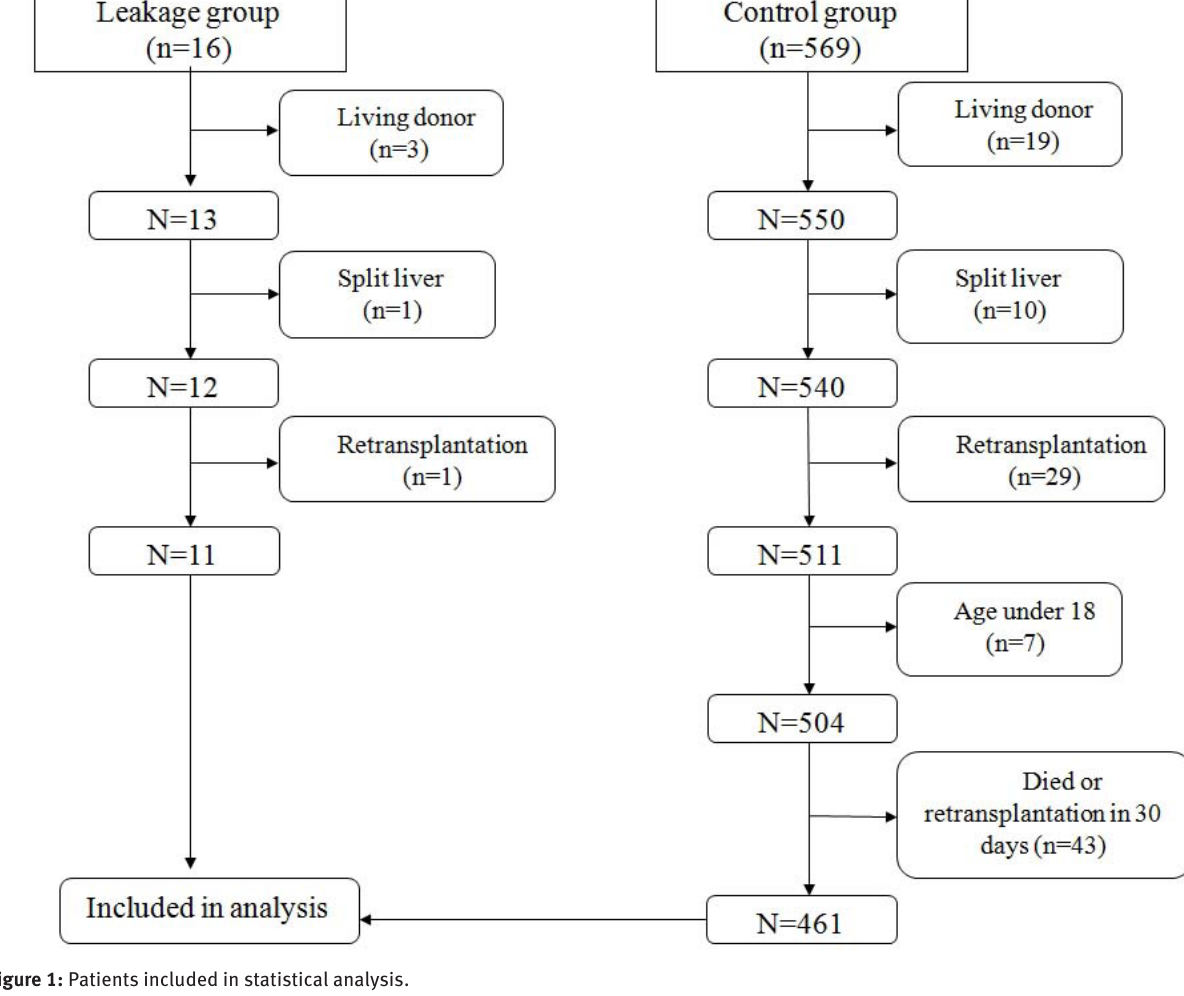
Figure 1: Patients included in statistical analysis.